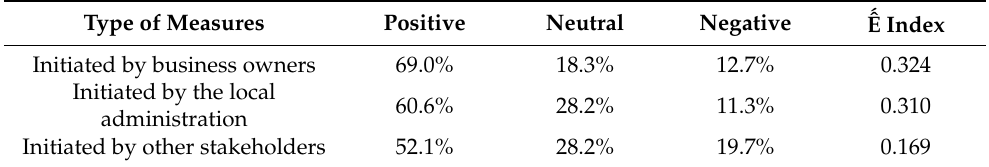
Table 3. Source of initiating activities to increase resilience and competitiveness at the level of local economy